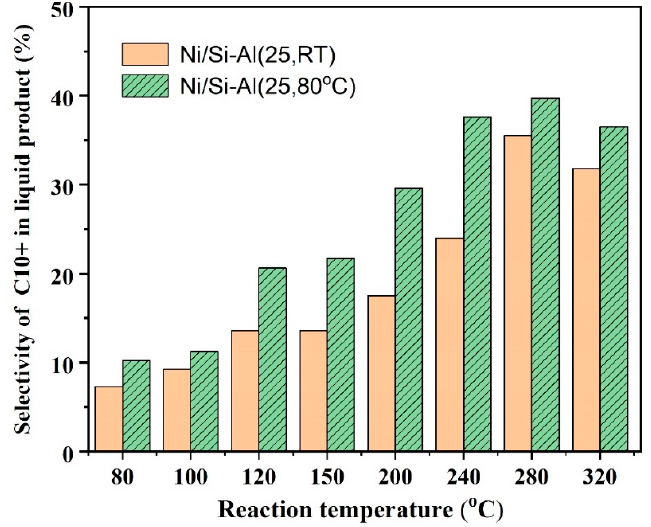
Figure 7. C 10+ product of ethylene oligomerization catalyzed by Ni/Si ‐ Al (25, RT) and Ni/Si ‐ Al (25, 80) at different reaction temperatures. Reaction conditions: pressure: 3.5 MPa; WHSV: 2.0 h − 1 ; Ni precursor: Ni(NO 3 ) 2 ; aging temperature: room temperature; pretreatment temperature: 300 ° C.